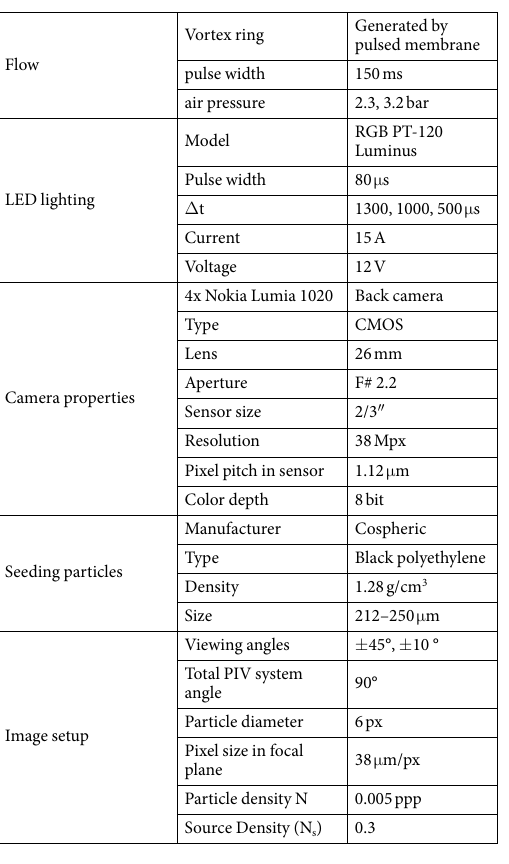
Table 1. Summary of parameters used for capturing tomographic PIV images of a vortex ring.